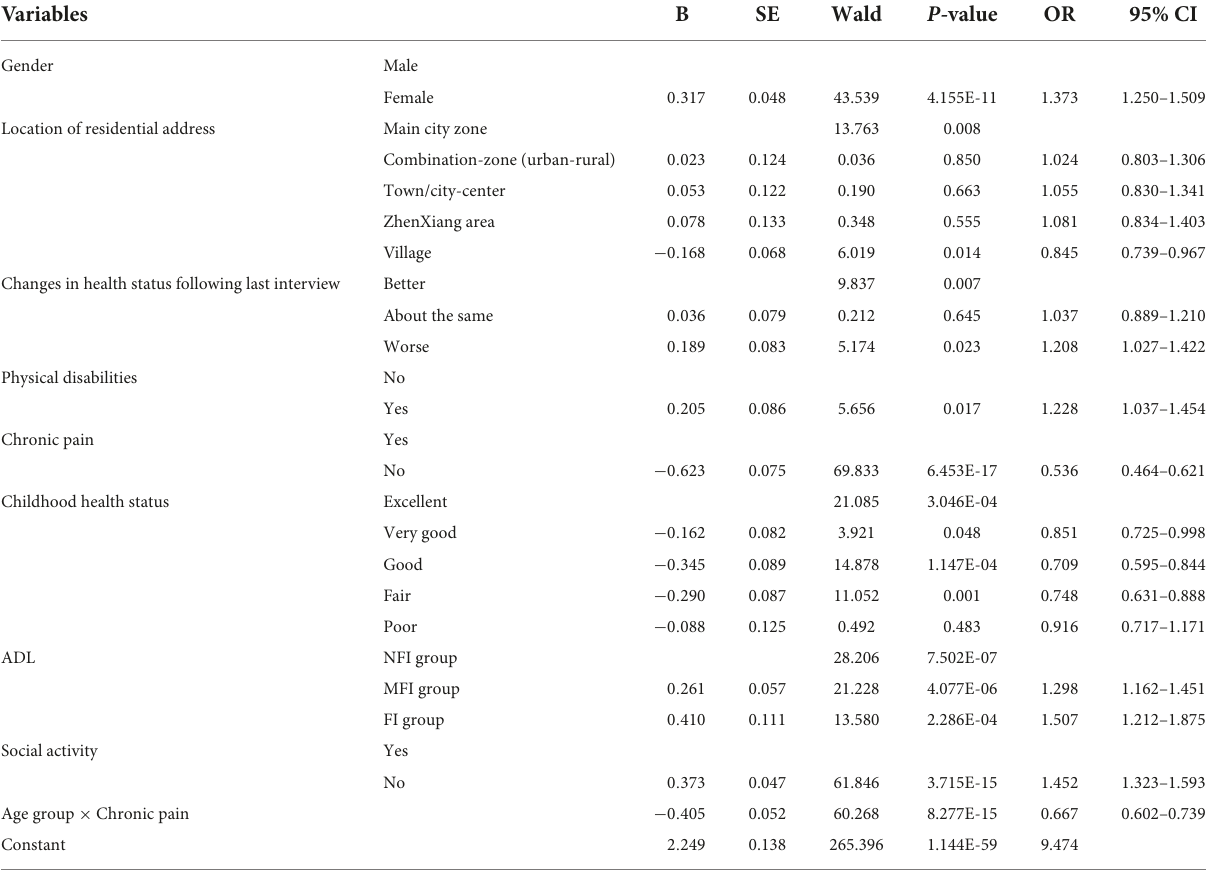
TABLE 3 Binary logistic regression analysis of related factors of depressive